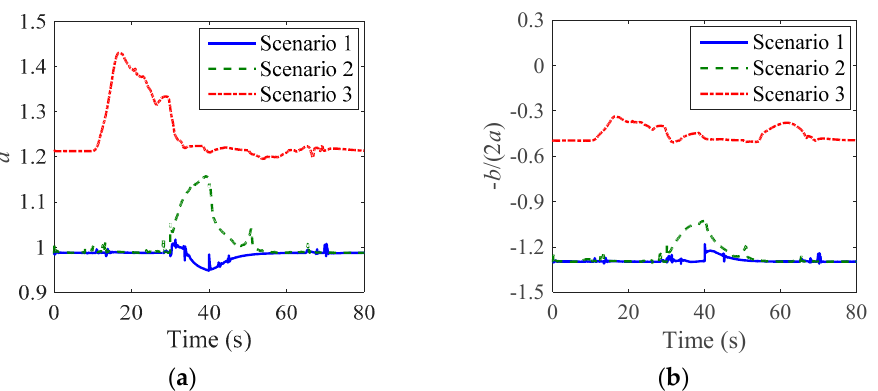
Figure 14. The parameter variation curve of the quadratic function. ( a ) Second-order coefficient a . ( b ) Axis of symmetry − b /2 a .